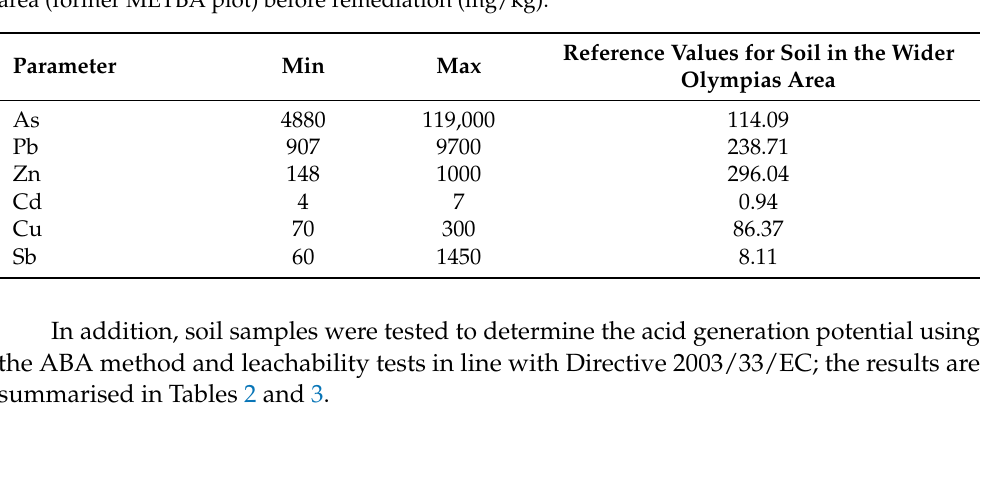
Figure 3. Soil sampling grid at the old arsenopyrites concentrate storage area (former METBA plot) before remediation. Table 1. Heavy metal content of surface soil samples from the old arsenopyrites concentrate storage area (former METBA plot) before remediation